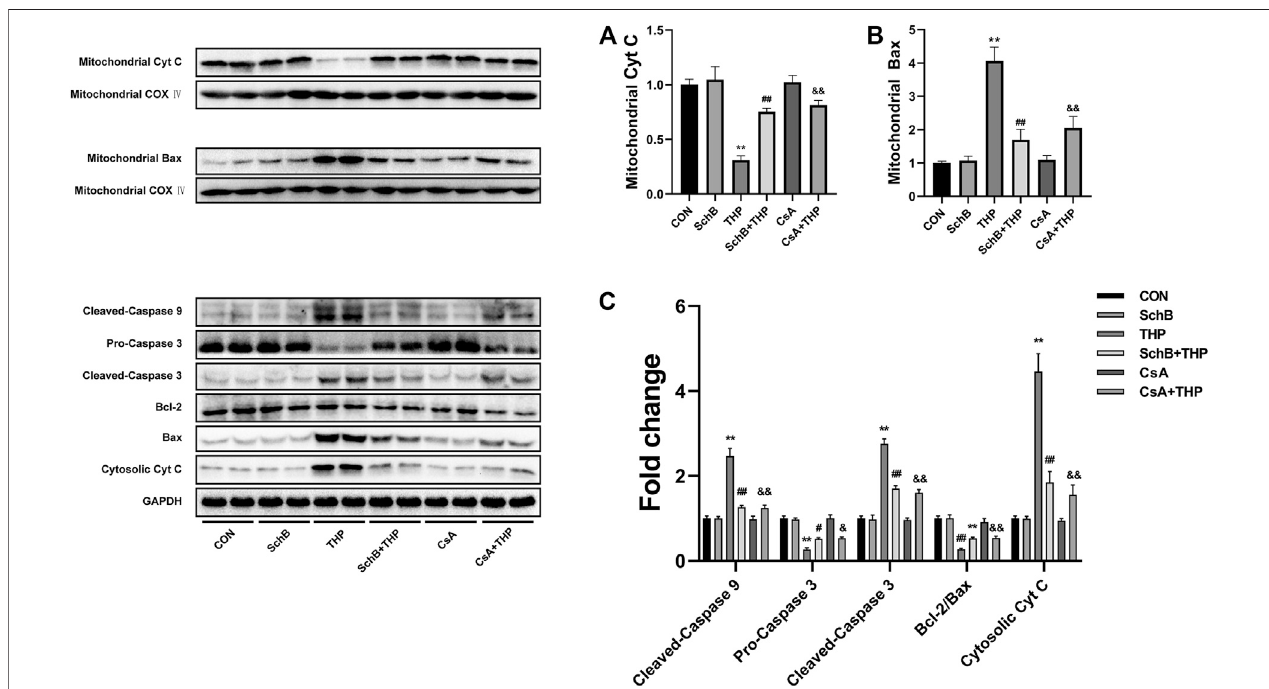
FIGURE 7 | SchB ameliorates THP-induced abnormal expression of apoptosis-related proteins in rat heart. THP caused the decrease of Cyt C (A) and increase of Bax (B) content in mitochondria. The above changes were alleviated by the treatment of mPTP inhibitor CsA. SchB treatment showed similar effects. In addition, THP also increased the expression of Cyt C and cleaved-caspase 3/9, decreased the expression of procaspase 3, and decreased the ratio of Bcl-2/Bax in cytoplasm (C) . After treatment with SchB or CsA, the above changes were alleviated effectively (C) . More evidence can be found in the semiquantitative analysis (A – C) . All values are mean ± SD. *p < 0.05 vs. CON , ** p < 0.01 vs. CON , # p < 0.05 vs. THP , and ## p < 0.01 vs. THP .